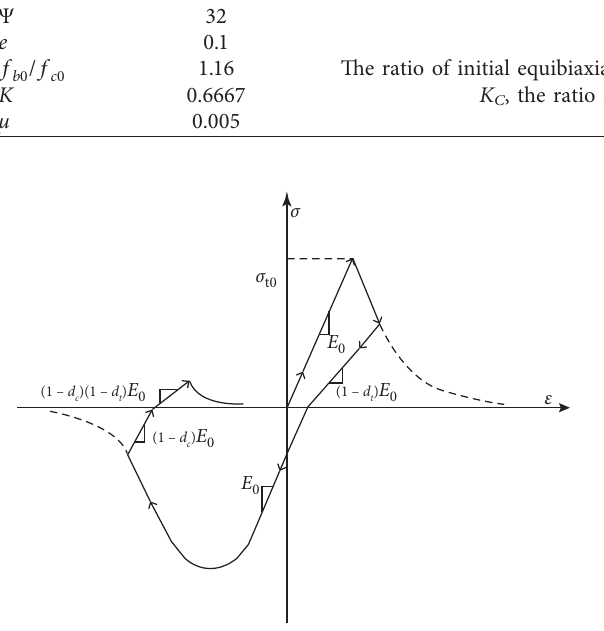
Figure 6: A single, uniaxial tensile-compressive loading cycle.